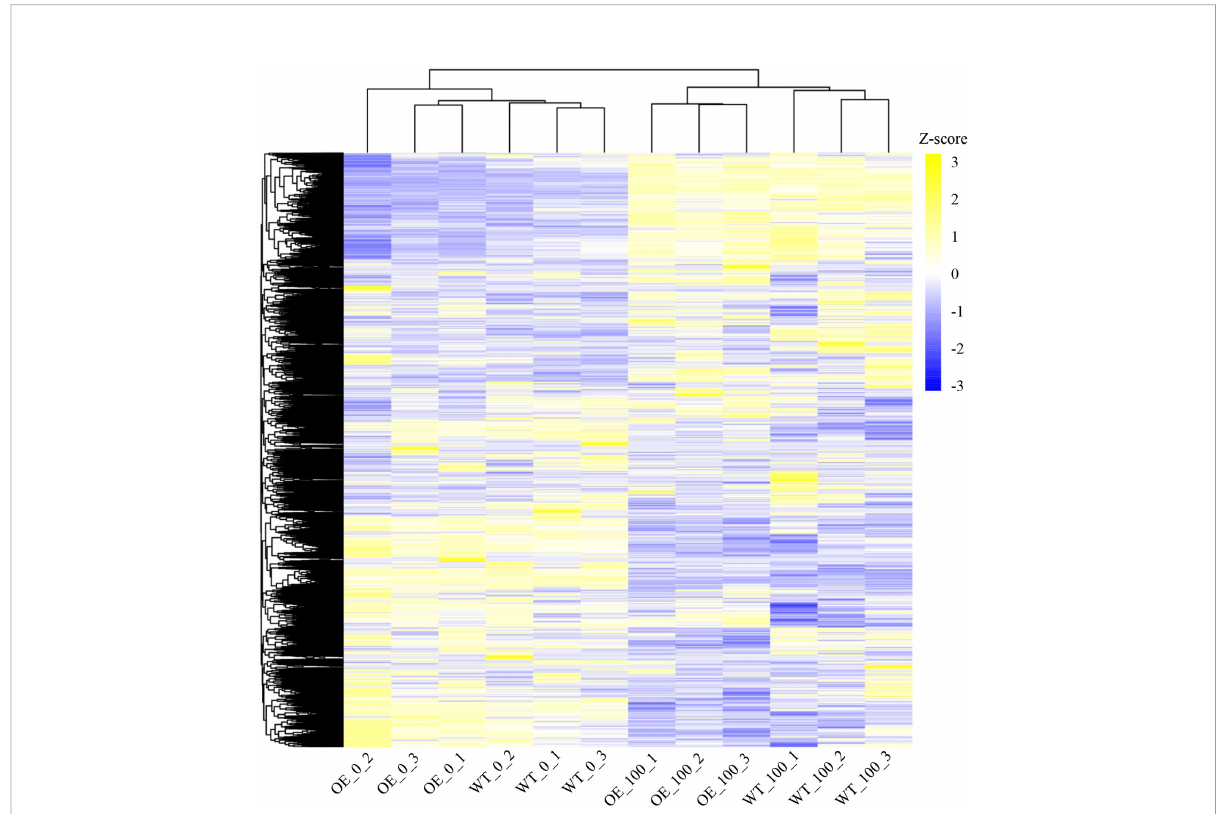
FIGURE 3 Different response of genes to salt stress between WT and NbCIPK25 transgenic plants. Heat map representation for all genes identi fi ed in the transcriptome shown as colored boxes along with corresponding data for fragments per kilobase of transcript per million mapped reads (FPKM). Z-score is used to evaluate the relative expression level of genes in rows. Blue in color-coded boxes indicates a relative low FPKM value, and yellow indicates a relative high FPKM value in rows. OE_0 and OE_100 represent NbCIPK25 transgenic plants under 0 or 100 mM NaCl treatment, respectively; WT_0 and WT_100 mean WT plants under 0 or 100 mM NaCl treatment,